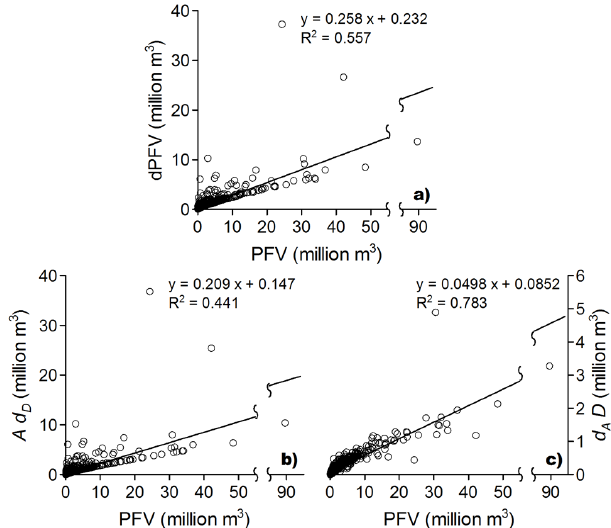
Fig. 9. Uncertainties of (a) potential flood volume (dPFV), due to (b) depth estimation ( Ad D ) and (c) lake area delineation ( d A D ) against the potential flood volume (PFV). A and D in the vertical axes denote area and depth of lake, respectively.